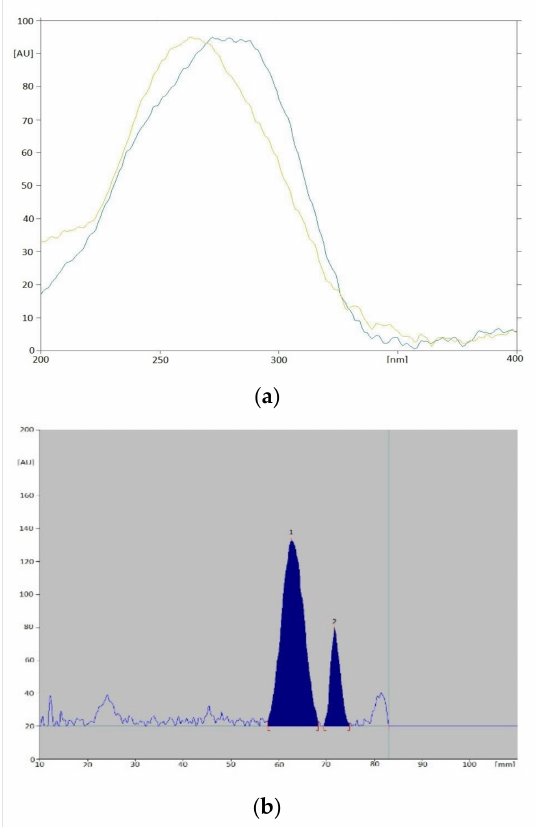
Figure 7. Absorption spectra in the UV range (( a ); light green line—D 3 , dark green line—X) and an example densitogram (( b ); 1—D 3 , 2—X) recorded for Product